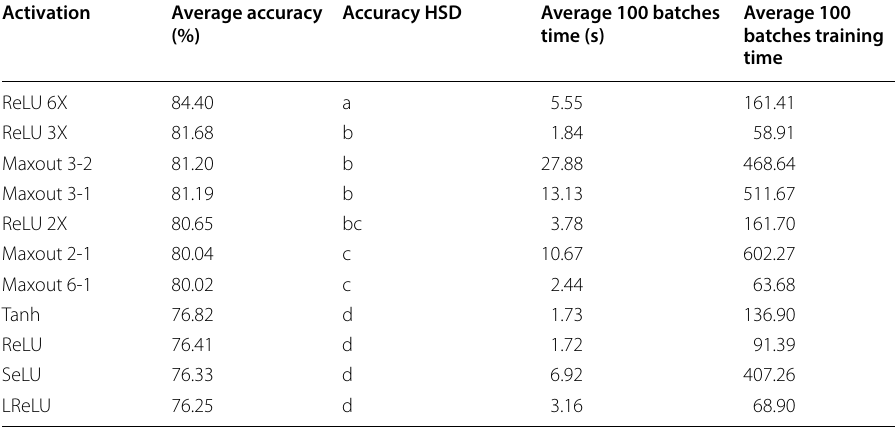
Table 10 Activation HSD test on image and face datasets Activation Average accuracy (%)